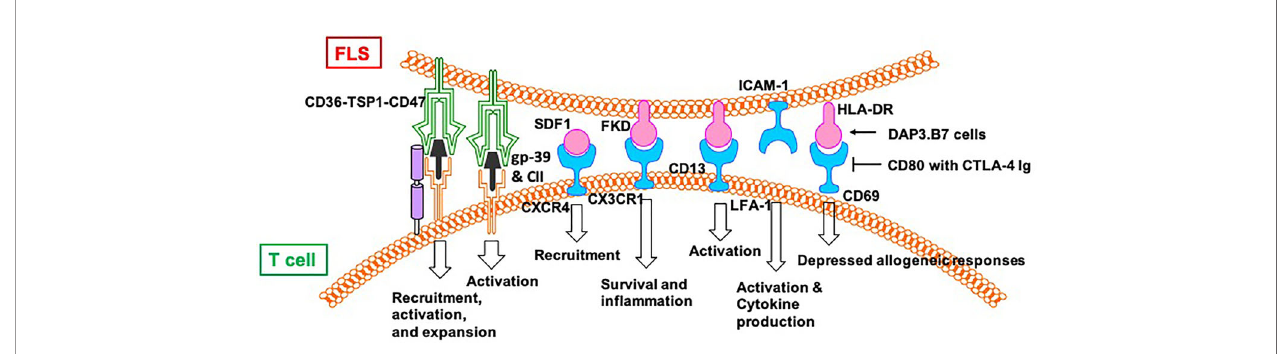
FIGURE 4 | FLS directly regulate functions of T cells in